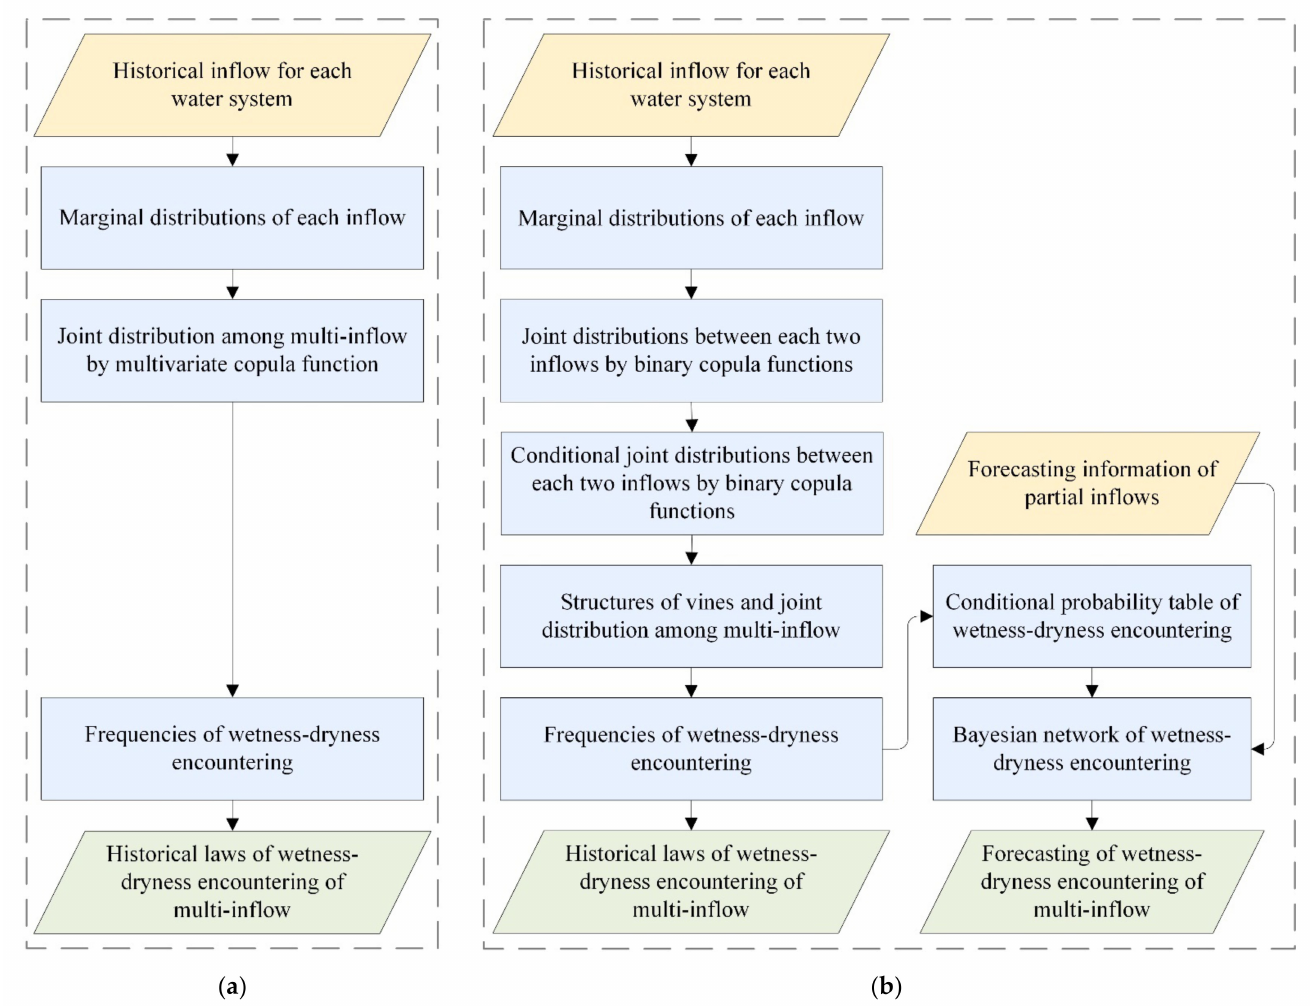
Figure 3. The flow chart for analysis and forecasting of wetness-dryness encountering of a multi-water system: ( a ) The flow chart for analysis of wetness-dryness encountering of multi-water system based on a conventional copula function; ( b ) the flow chart for analysis and forecasting of wetness-dryness encountering of a multi-water system based on the vine copula function-Bayesian network.